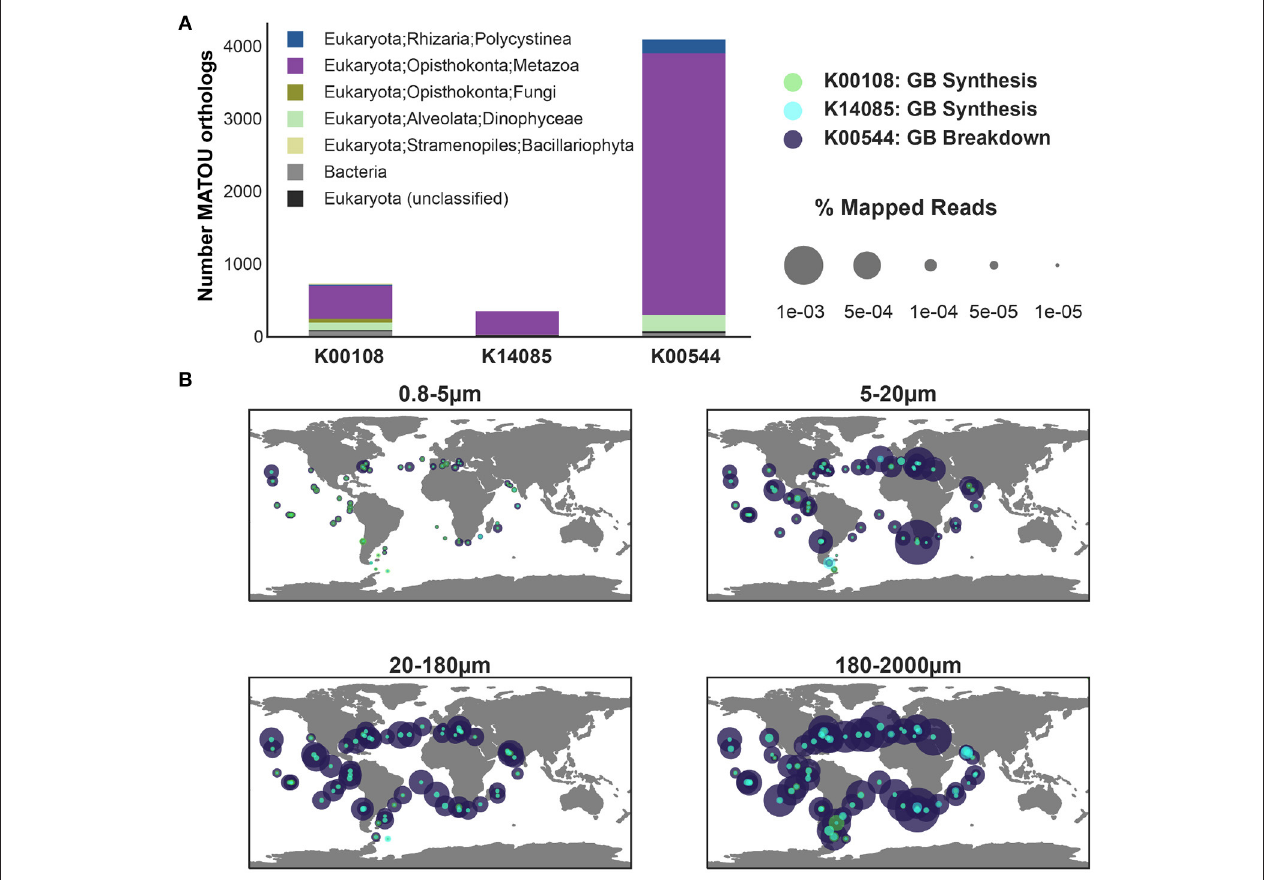
FIGURE 6 | The abundance and diversity of KOs associated with the synthesis and breakdown of glycine betaine across eukaryotic metatranscriptomic data from Tara Oceans. Genes included in the analysis: Betaine-homocysteine S-methyltransferase (K00544), a central enzyme for the breakdown of glycine betaine, 4267 orthologs of K00544 were identified in the MATOU-v1 dataset; choline dehydrogenase (K00108), 826 orthologs recovered; aldehyde dehydrogenase A1 (K14085), 384 orthologs recovered. (A) The taxonomic breakdown of the orthologs as published in MATOU-v1 is depicted as stacked bar plot (top). (B) The relative abundance of the three KOs ( Supplementary Figures 7, 8 ) in the eukaryotic metatranscriptome dataset from the surface ocean in Tara is shown by size fraction (0.8 − 5 µ m ,5 − 20 µ m ,20 − 180 µ m , and 180 − 2,000 µ m